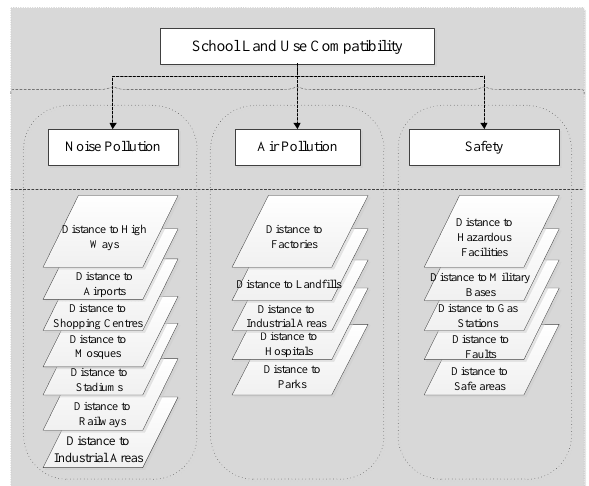
Figure 1. Data layer used in previous